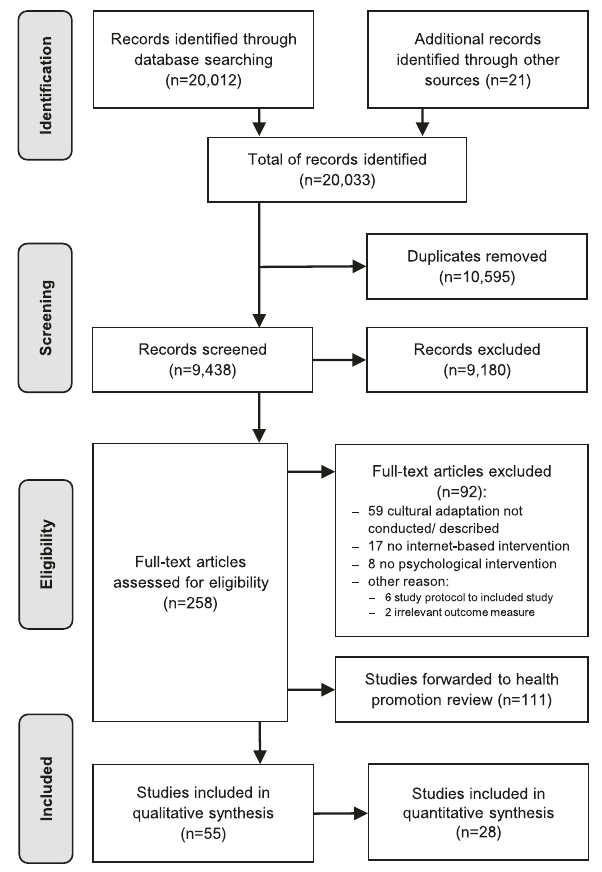
Fig. 1 PRISMA study fl ow chart. Process of study identi fi cation, screening, eligibility veri fi cation, and inclusion decision (adapted from Liberati et al. 115